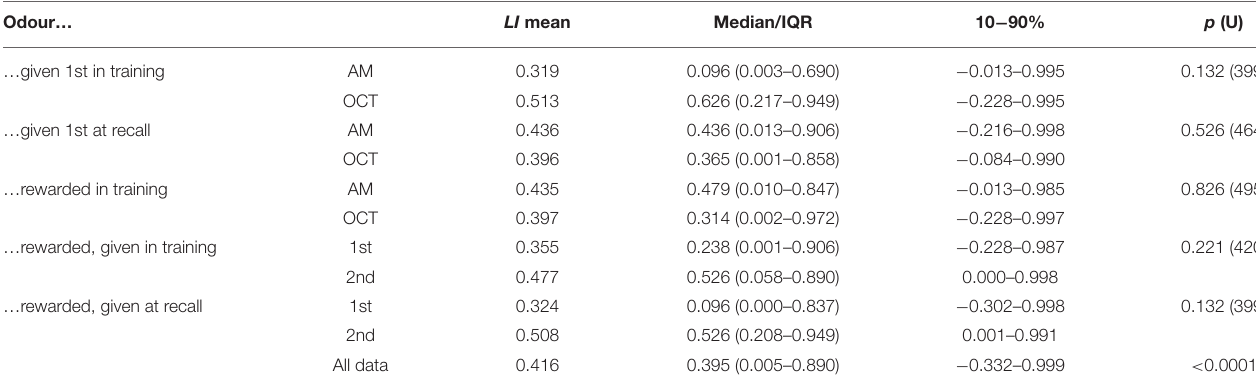
TABLE 5 | Data from tests for differences in learning index ( LI ) based on the P resp values for the eight permutations of the differential olfactory conditioning paradigm ( Table 4 ). Odour… LI mean …given 1st in training